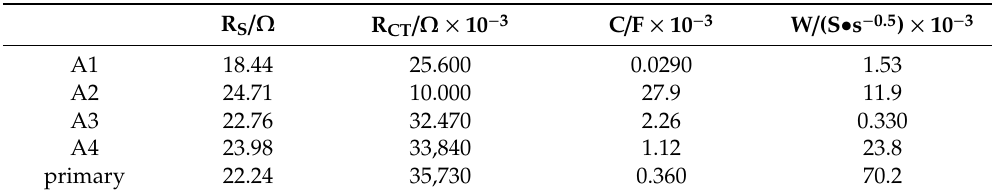
Table 1. The Alpha diversity of the four activated sludge